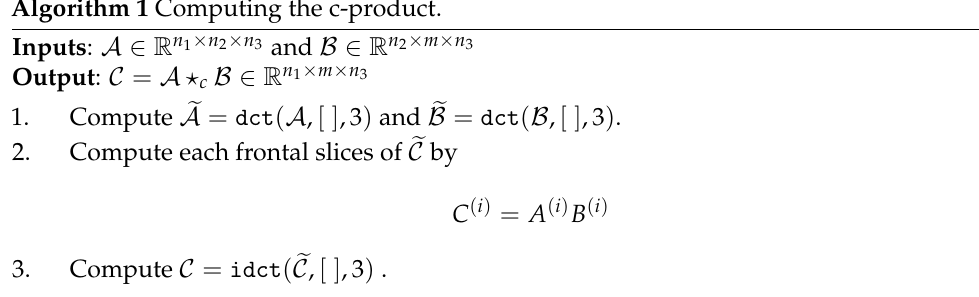
Algorithm 1 Computing the c-product.